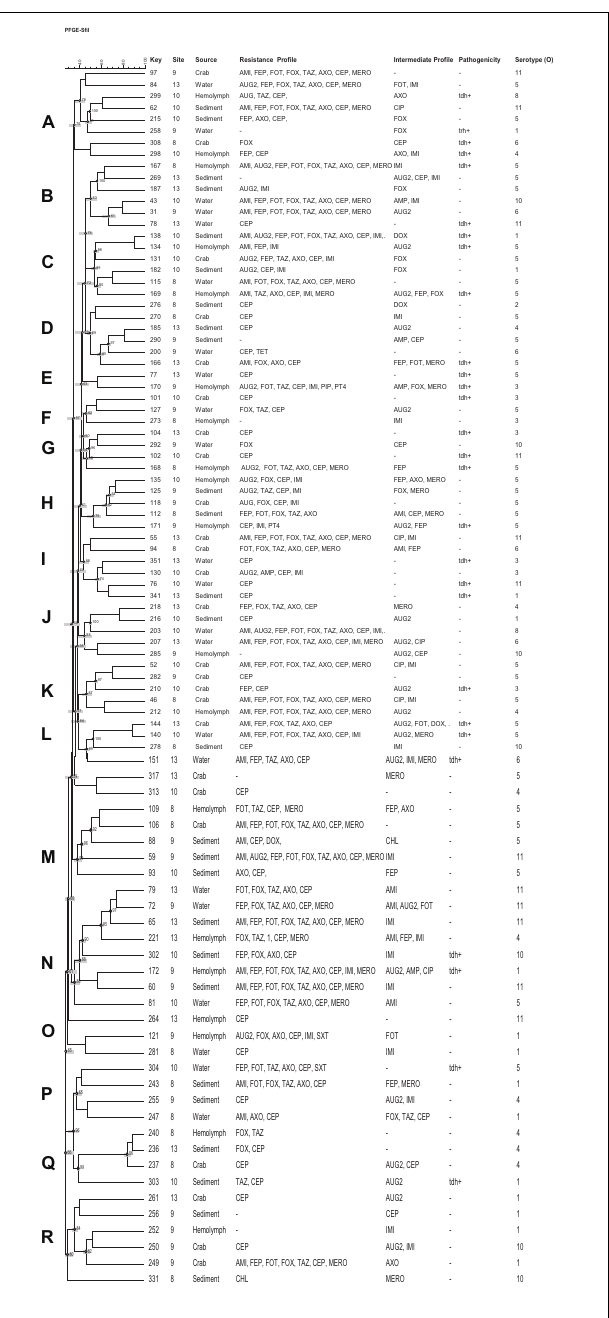
FIGURE 5 | Dendrogram of PFGE profiles of Vibrio parahaemolyticus strains collected form crab and its environment in Maryland Coastal Bays; Site 8–Chincoteague Bay; 9–Newport Bay; 10–Sinepuxent Bay; 13–St. Martin River. Key = stain number. AMI, amikacin; AUG2, amoxicillin/clavulanic acid; AMP, ampicillin; A/S2, ampicillin-sulbactam; FEP, cefepime; FOT, cefotaxime; FOX, cefoxitin; TAZ, ceftazidime; AXO, ceftriaxone; CEP, cephalothin; CIP, ciprofloxacin; CHL, chloramphenicol; DOX, doxycycline; IMI, imipenem; LEVO, levofloxacin; MERO, meropenem; PIP, piperacillin; P/T4, piperacillin/ tazobactam; TET, tetracycline; SXT, trimethoprim/sulfamethoxazole; tdh, thermostable direct hemolysin. Letters A to R on the left represent pulsed-field gel electrophoresis clusters; key represent strain numbers; minus sign (-) on the resistance and intermediate profiles columns indicates “no resistance” or “no intermediate” profiles and on the Pathogenicity column (-) indicates tdh and trh negative; Serotype (O) =